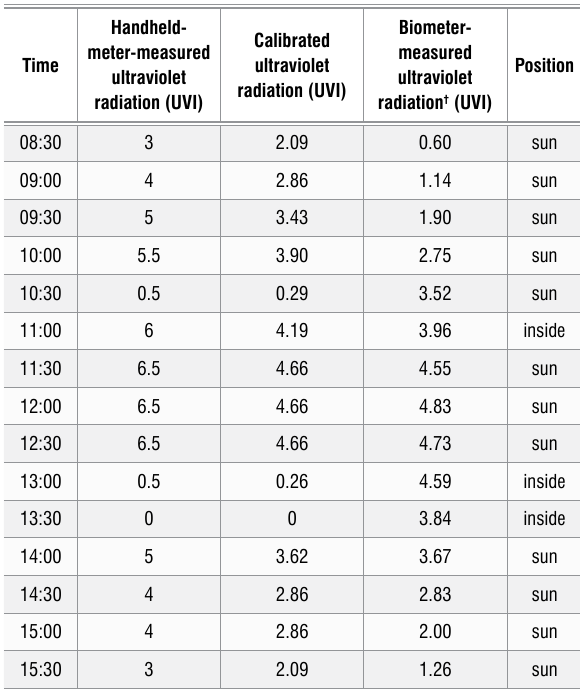
Table 3: Ultraviolet radiation values and position of outdoor worker on Day 2 of fieldwork Handheld- Calibrated meter-measured ultraviolet Time ultraviolet radiation (UVI)